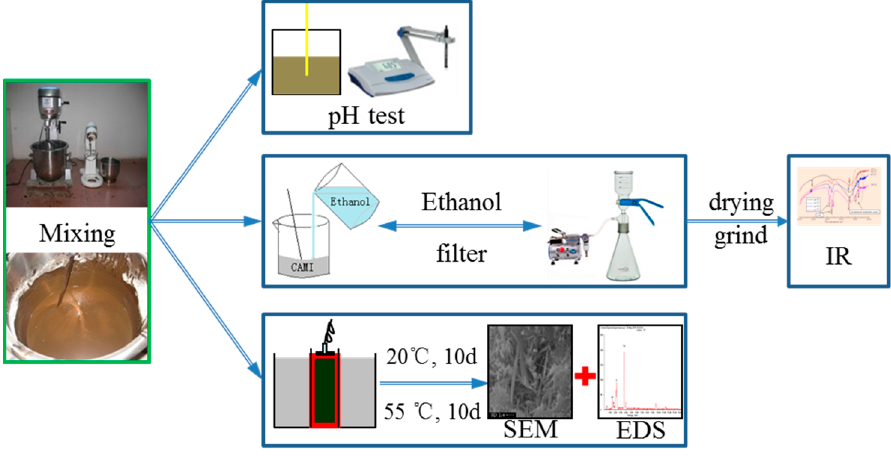
Figure 5. The diagram of experimental steps.